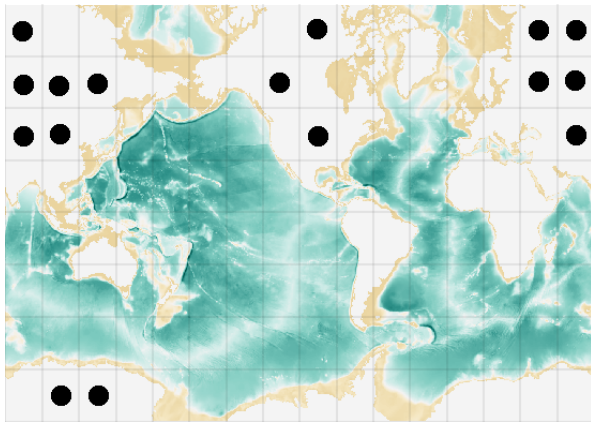
Figure 4. Domain decomposition of a tripolar grid of the ORCA family with a resolution of 1.0 ◦ into 128 subdomains (16 × 8). Sub- domains marked with a black dot do not contain any ocean grid